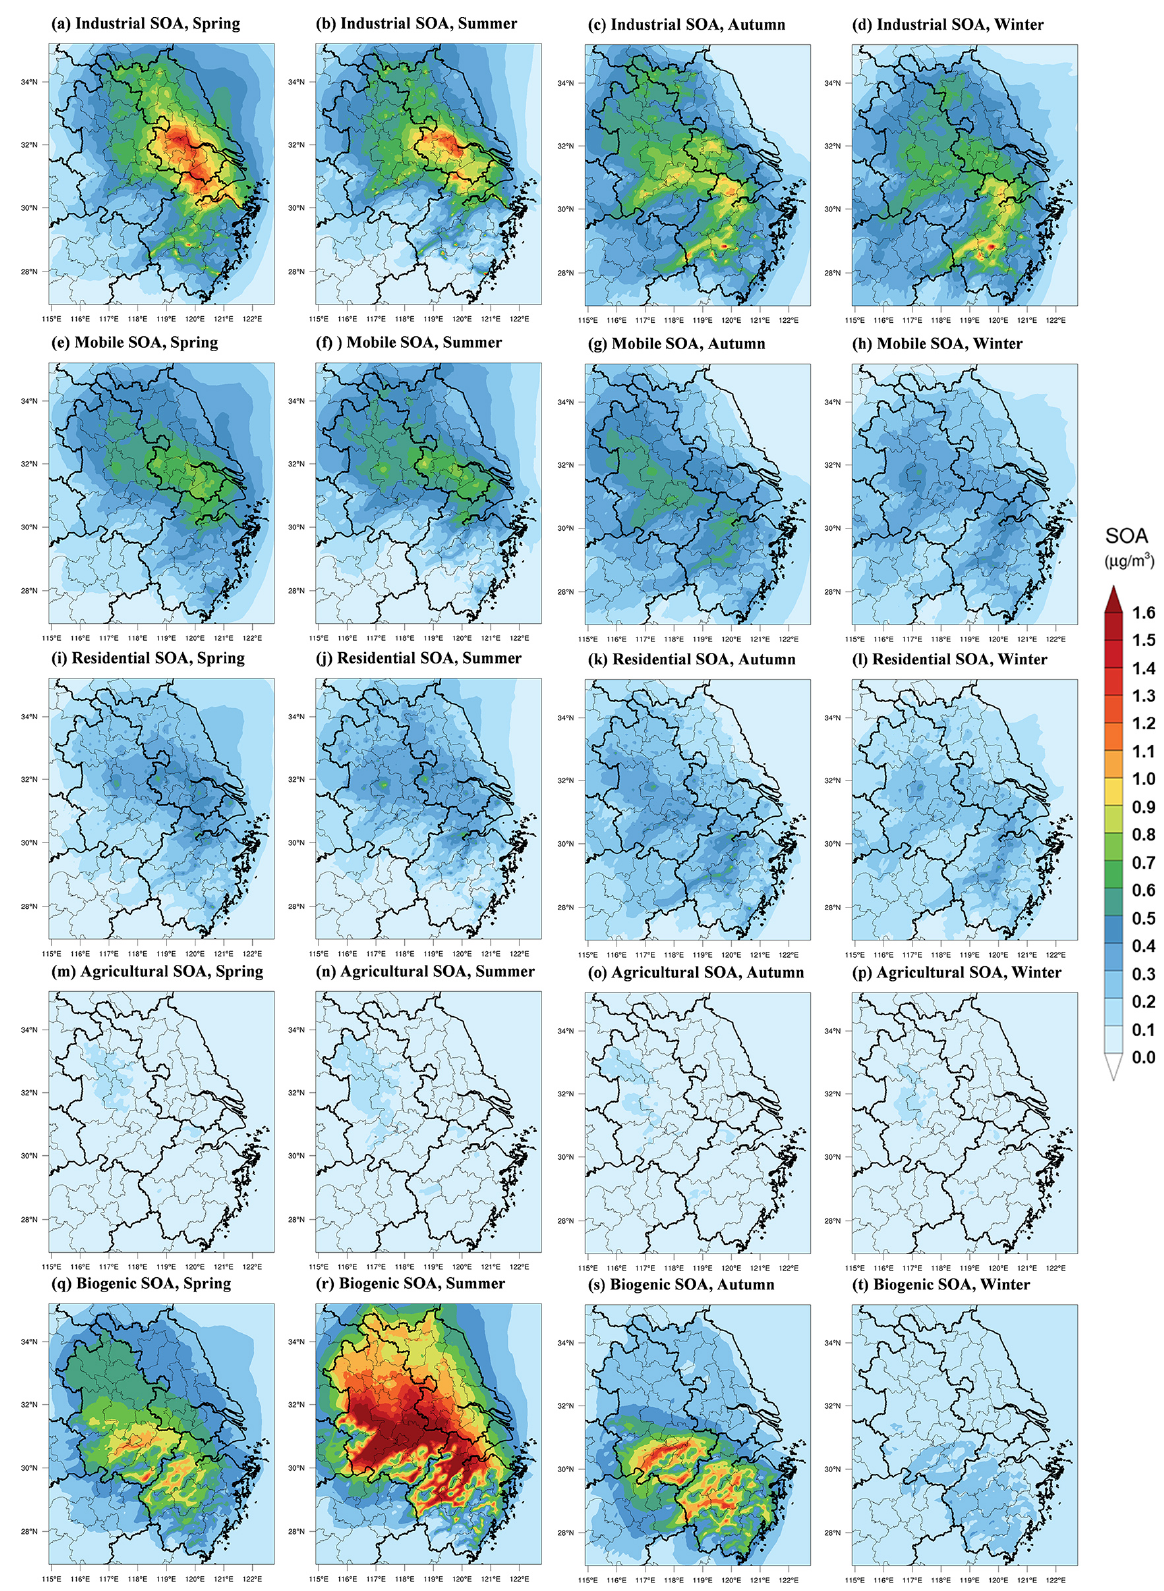
Figure 8. Spatial distributions of modeled SOA concentrations from different sources in each season in the YRD region.